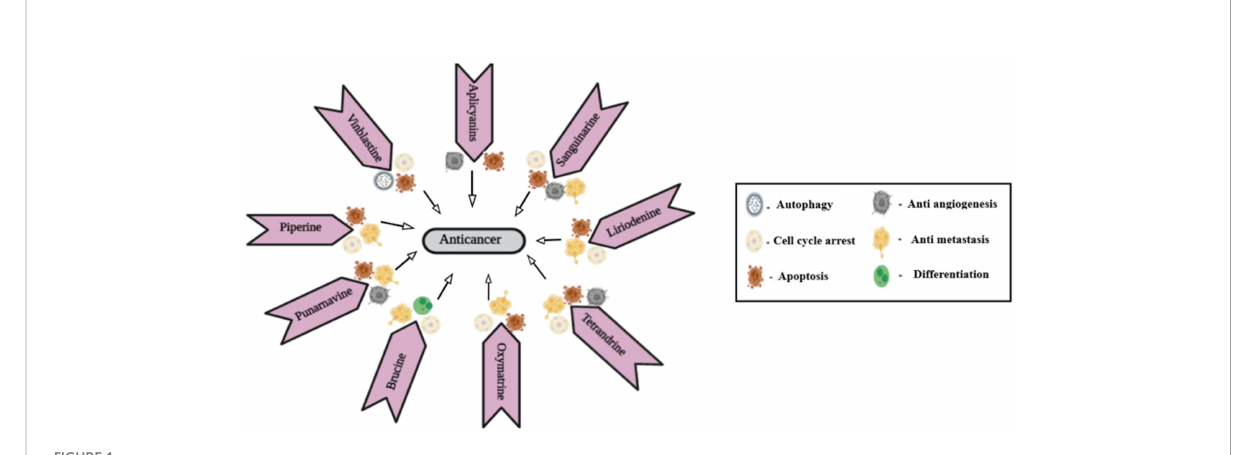
FIGURE 1 Mechanism of action of different